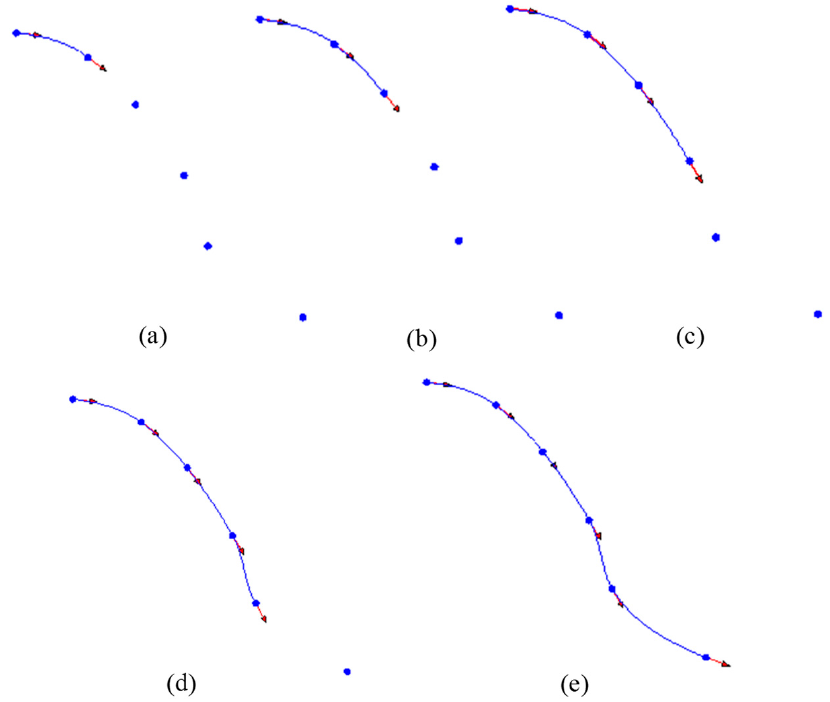
Figure 8. Akima spline fitting ( a ) the first Akima spline ( b ) the second Akima spline ( c ) the third Akima spline ( d ) the fourth Akima spline ( e ) the fifth Akima spline.